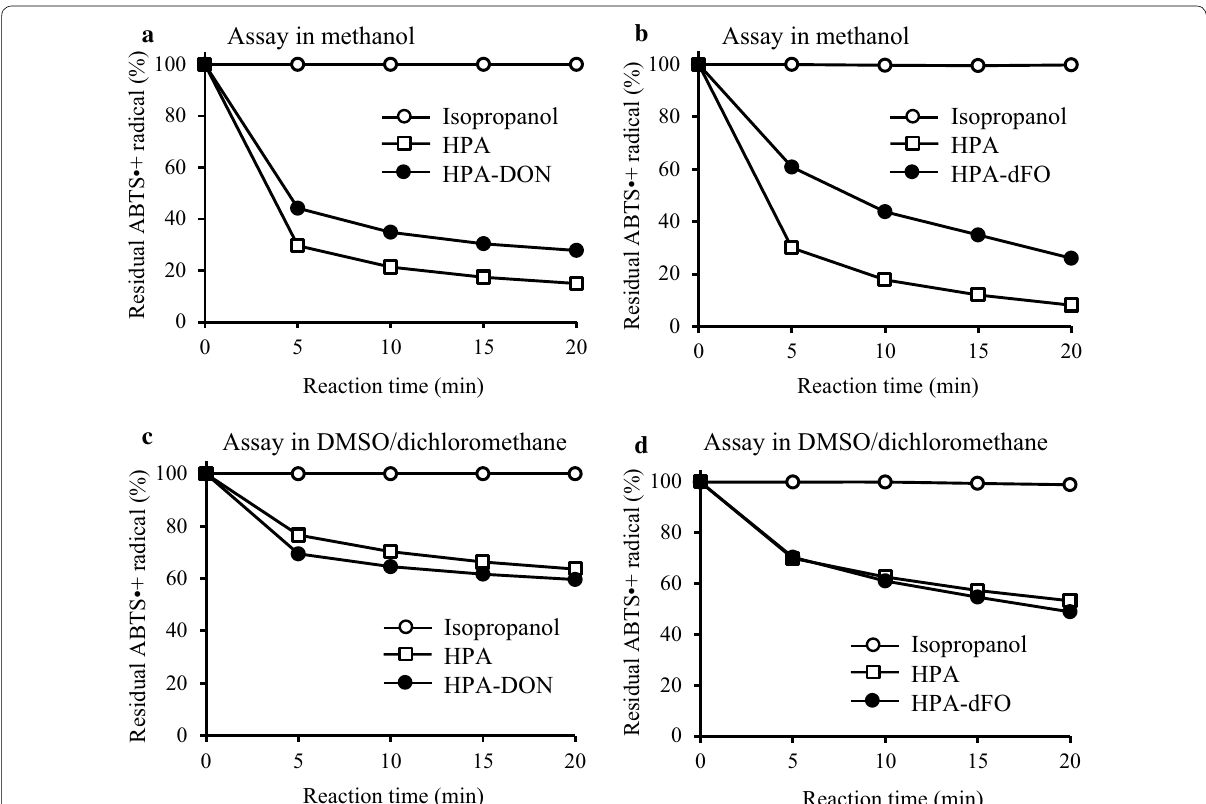
Fig. 4 ABTS • + radical scavenging using HPA-DON and HPA-dFO. ABTS • + radical scavenging activity was measured using HPA-DON (left column), and HPA-dFO (right column). Assay was performed in a and b methanol, and c and d DMSO/dichloromethane (2:8. v/v) systems, using isopropanol ( ○ ), 10 mM HPA ( □ ), and 10 mM HPA-DON (or HPA-dFO) ( ●